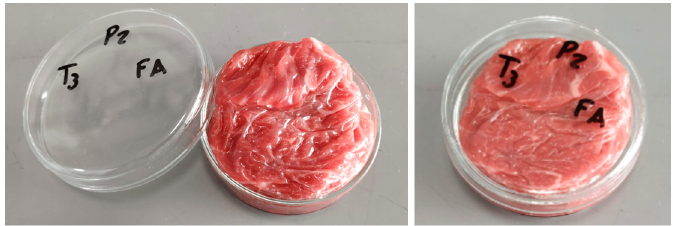
Figure 1. Meat wrapped with alginate films in the Petri dish.